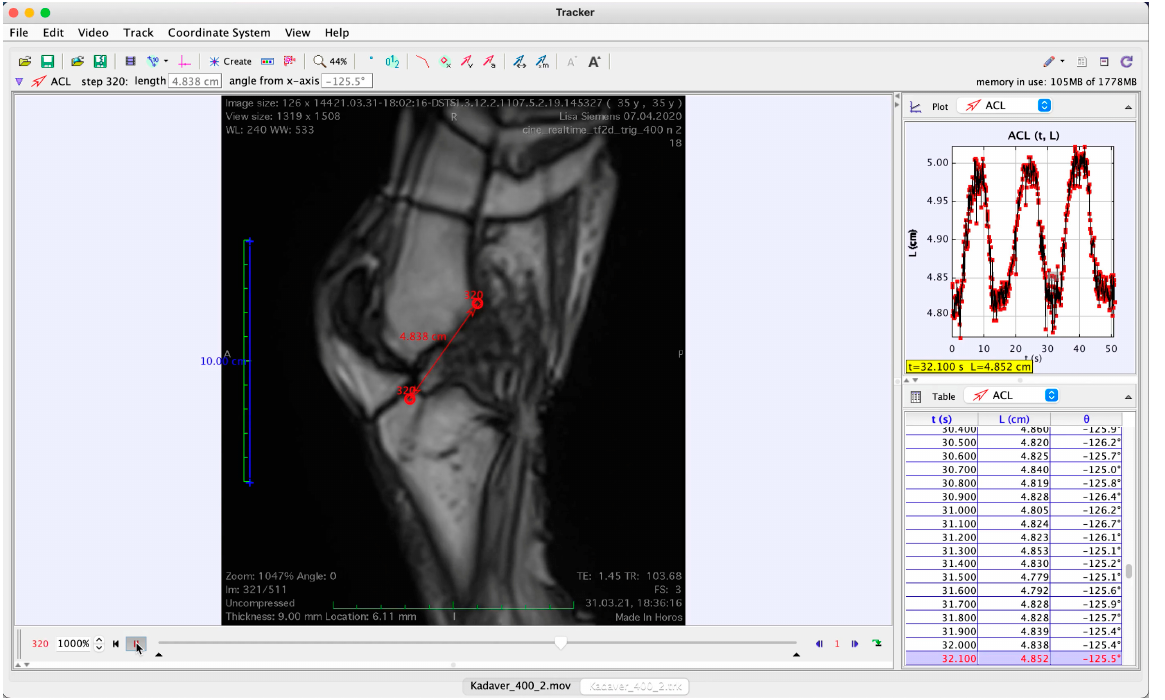
Figure 3. Screenshot of MRI cine sequence with points tracked for the estimation of ACL elongation. The red dots represent the points tracked during test execution.